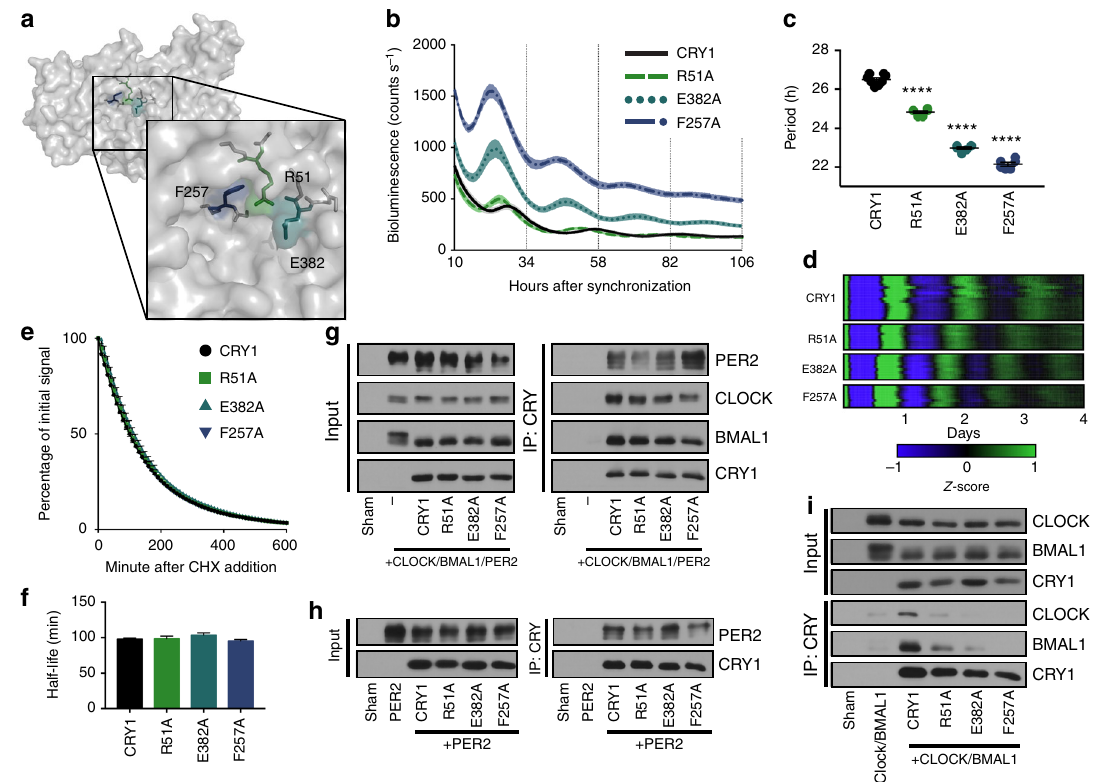
Fig. 5 Weakened interaction between CRY1 and CLOCK/BMAL1 dramatically shortens the period in rescue assays. a Surface view of CRY1 (PDB: 5T5X) with an inset magni fi cation of the secondary pocket. Residues R51, E382, and F257 are labeled and colored in green, teal, and navy blue. b Rescue assays performed with WT, R51A, E382A, and F257A CRY1 ( n = 8, 6, 6, and 6 per condition, respectively, re fl ective of 9 (R51A), 15 (E382A), and 12 (F257A) plates from three to fi ve independent experiments), shown as mean ± SEM. c Period plot for rescues shown in b . Mean± SEM indicated by bars. Asterisks indicate signi fi cance by unpaired t test with Welch ’ s correction (**** p < 0.0001). d Heat maps of CRY1 and mutant rescues demonstrate period and phase differences over multiple cycles. Raw data were baseline subtracted and z -scores were calculated, and then scaled to a range of − 1 to 1. The data from 16 WT, 9 R51A, 9 E382A, and 8 F257A plates are shown. e Degradation assay with CRY1::LUC and mutants ( n = 3 per condition). Samples were normalized to initial luminescence signal. Half-life was determined by fi tting a one-phase decay curve to the data. f Half-lives from e shown as means + SEM. No signi fi cant difference between WT and mutants by unpaired t test with Welch ’ s correction (R51A: p = 0.8245; E382A: p = 0.0660; F257A: p = 0.2029) g Co-IP assay with PER2, CLOCK, BMAL1, and CRY1 mutants. Blot is representative of three independent experiments. h Co-IP assay with PER2 and CRY1 mutants. Blot is representative of three independent experiments. i Co-IP assay with CLOCK, BMAL1, and CRY1 mutants. Blot is representative of